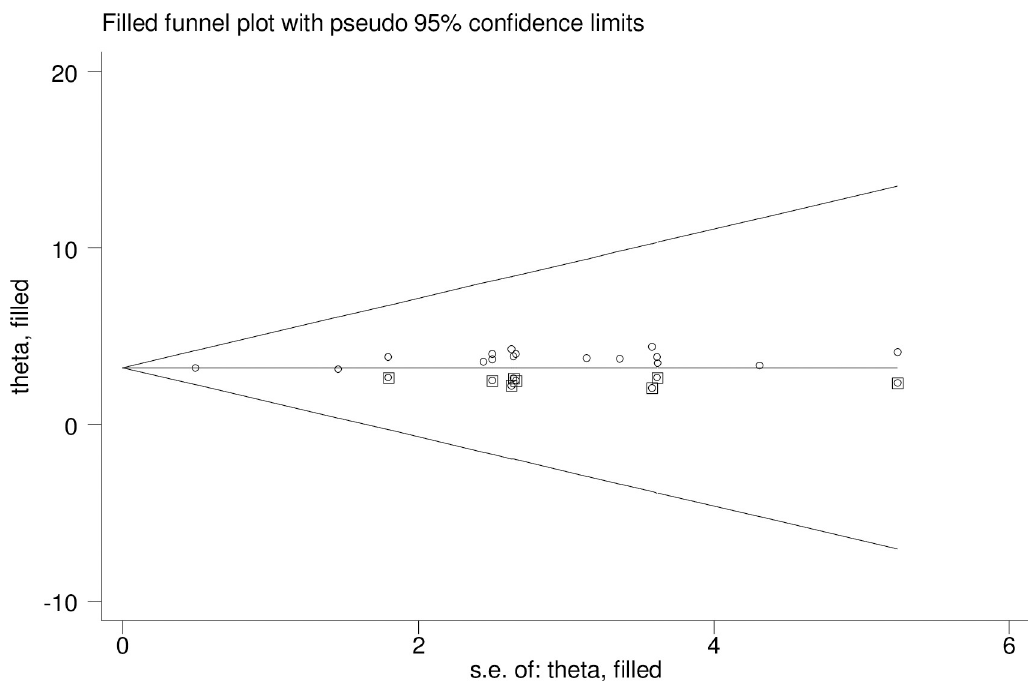
Fig 8. The funnel plot for trim-and-fill method was used to correct the result seven potential missing studies were required in the left side of the funnel plot to ensure symmetry. The enclosed circles represent the dummy studies and the free circles are genuine